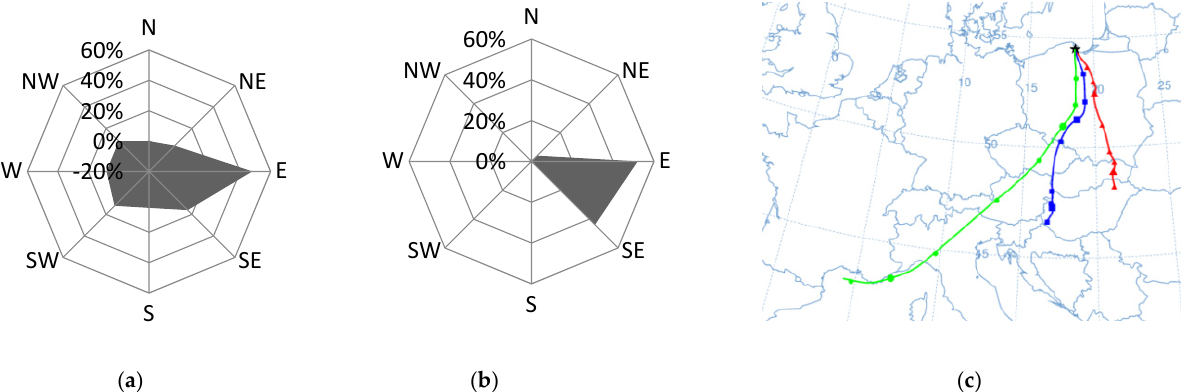
Figure 7. Dominant wind direction in the morning ( a ) and the afternoon ( b ) and dominant air masses ( c ) on 16 September 2015 in Gdynia.